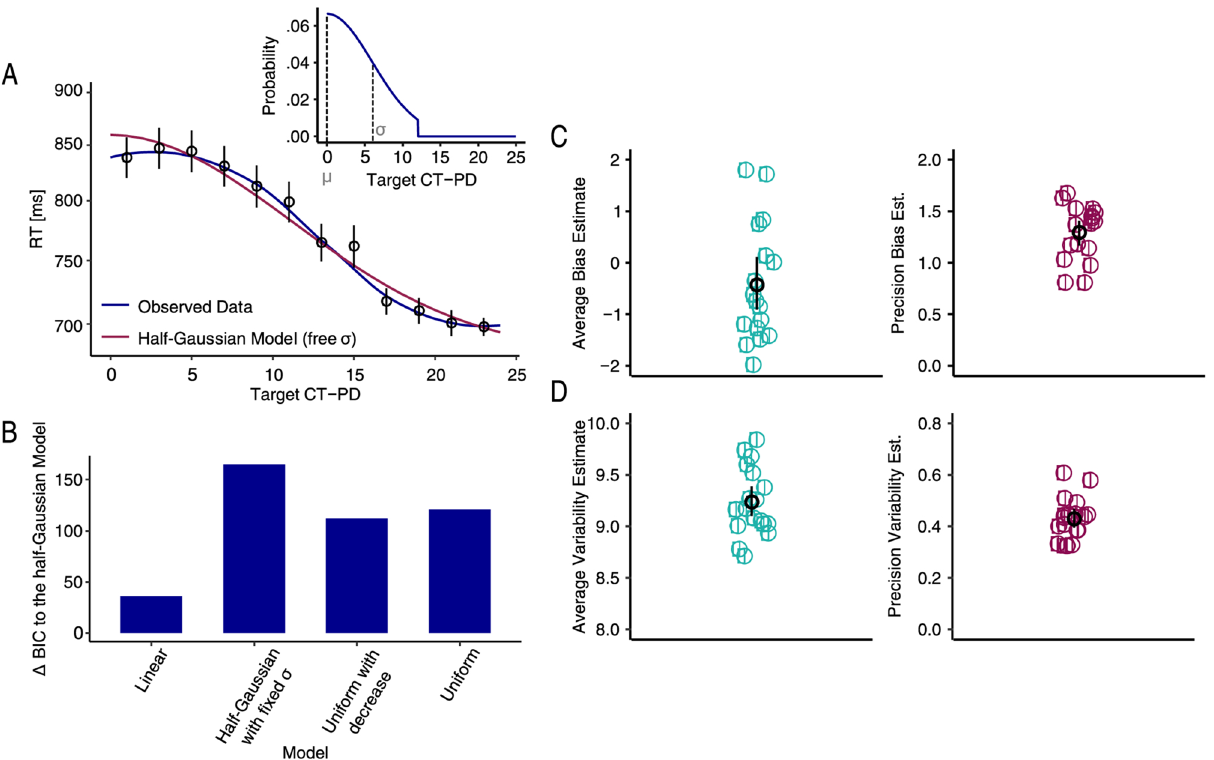
Figure 4. Estimates of ensemble properties obtained with the implicit method. Results plotted in ( A ) show the reaction time as a function of the target to distractor similarity and the best model fit using maximum likelihood estimation. The figure shows the search times on the test trials as a function of the distance between the target on the test trial and the mean of the previous distractor distribution in orientation space. Blue shaded areas show the 95% confidence intervals of the fitted loess function. Observed data after fitting the loess function is plotted in dark blue and the best model (a half-Gaussian model with a free sigma) is plotted in red. Data points correspond to the raw data binned over 2 JND’s across the x-axis. Error bars correspond to the 95% confidence intervals. The small insert corresponds to the underlying distractor distribution. The lower left panel ( B ) shows the differences between the BIC obtained from the best model (half-Gaussian model with a free sigma) and the BIC’s obtained from all other model fits (see text for details on the different models) and ( C ) and ( D ) show the location (μ) and variability (σ) of internal representations. The black data point corresponds to the mean across observers and the error bar represents the 95% confidence interval. Each colored data point refers to one